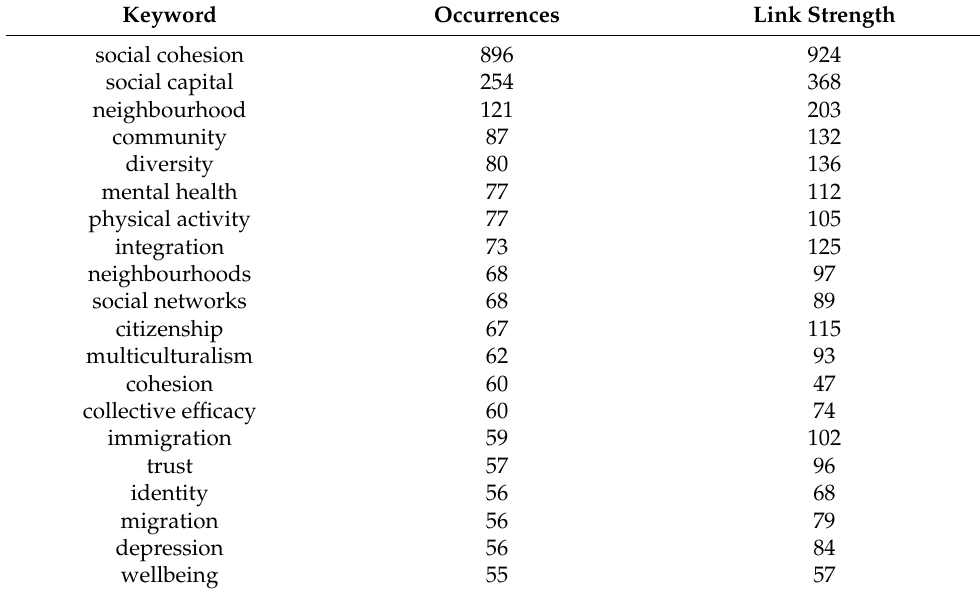
total number of links between a keyword and other